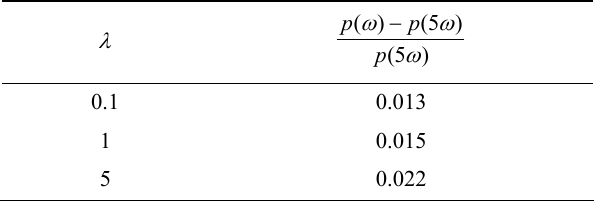
Fig. 8 In adhesive contacts, asperities with heights less than the separation of two surfaces are in contact. The pull off force is negligible for small adhesion parameters and it is more effective in high adhesion parameter. Table 2 The pressure change in contact for Gumble distribution p d with different adhesion parameters. is the dimesionless p d A d pressure in separation d , and  is surface